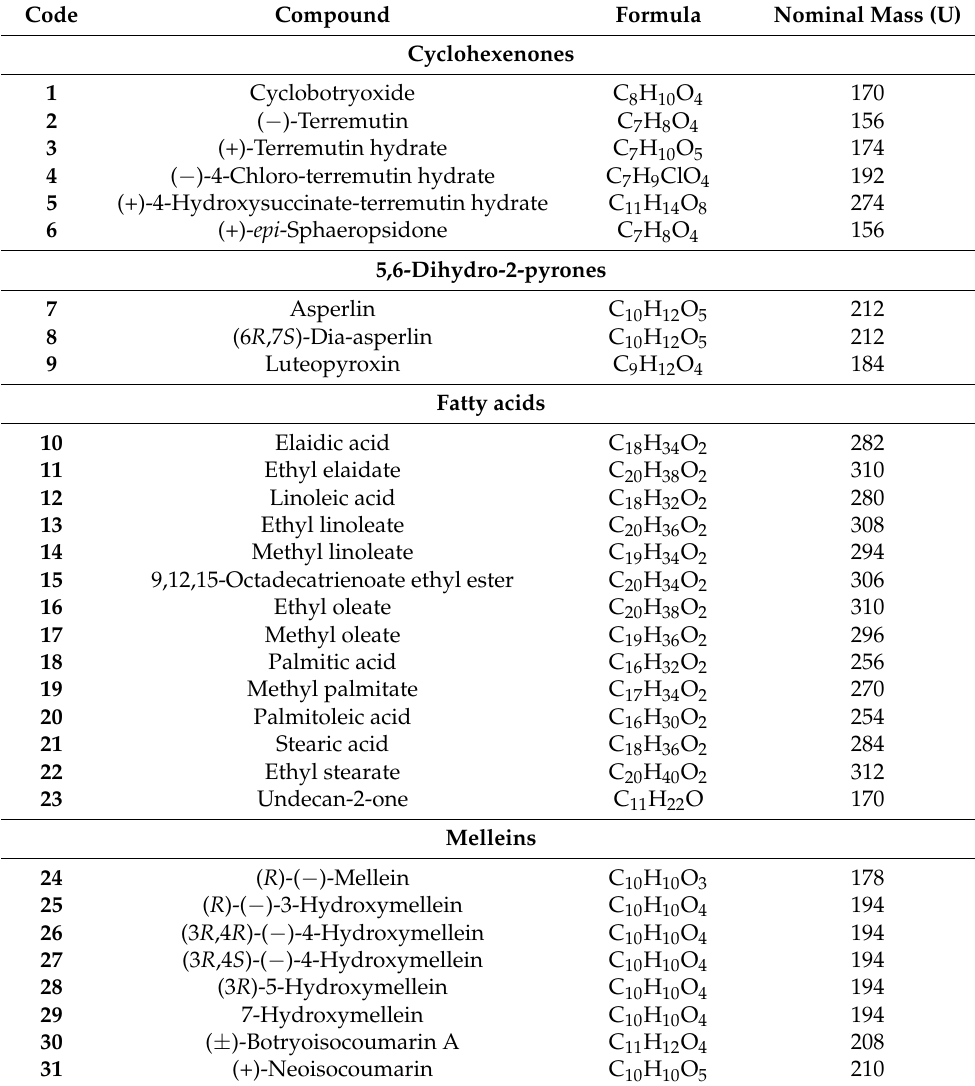
Table 1. List of secondary metabolites produced by Neofusicoccum